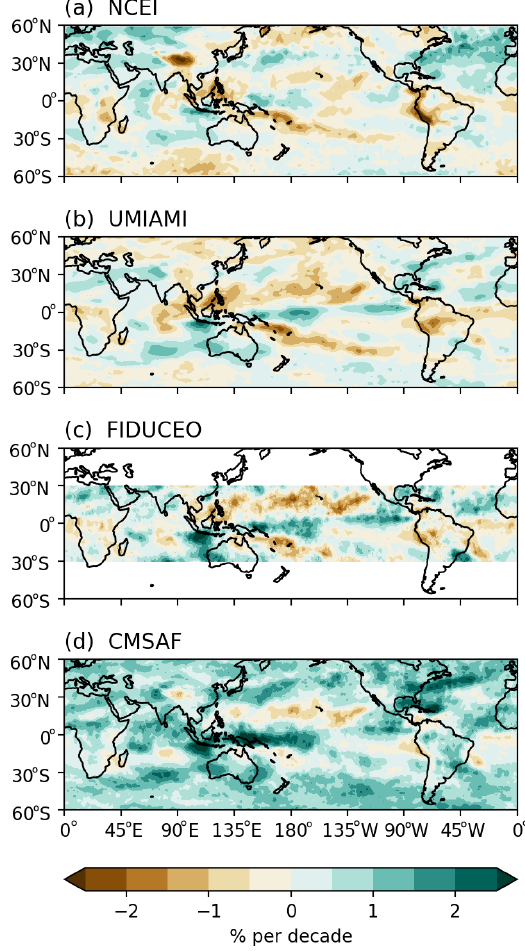
Figure 12. Change rates of the four UTH datasets during the com- mon period 1999 to